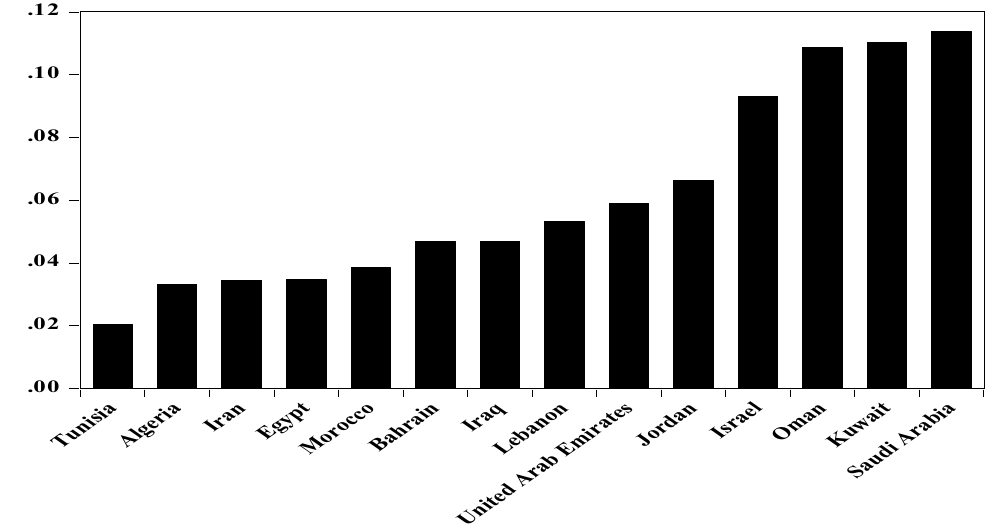
Fig. 2 Military spending in selected MENA countries (% of GDP)